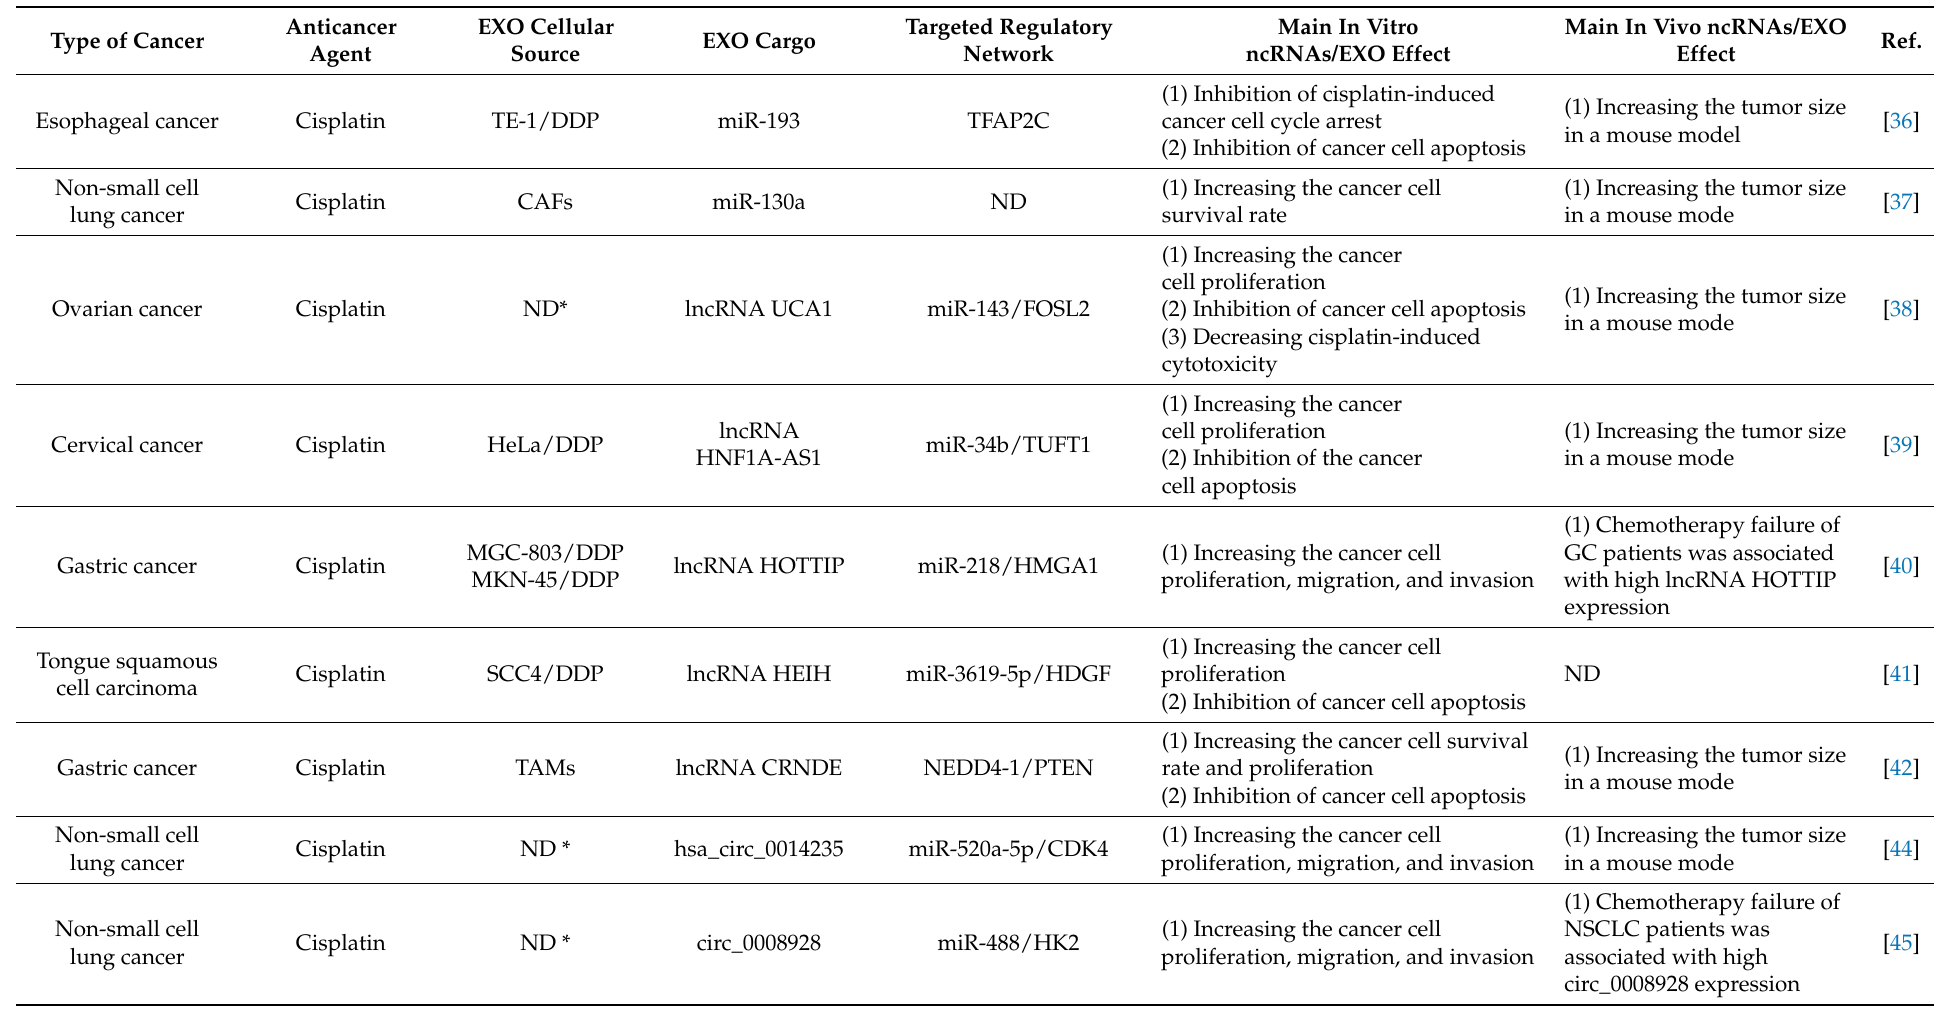
Table 1. Detailed analysis of exosomal non-coding RNAs (ncRNAs) mediated resistance to platinum-based anticancer